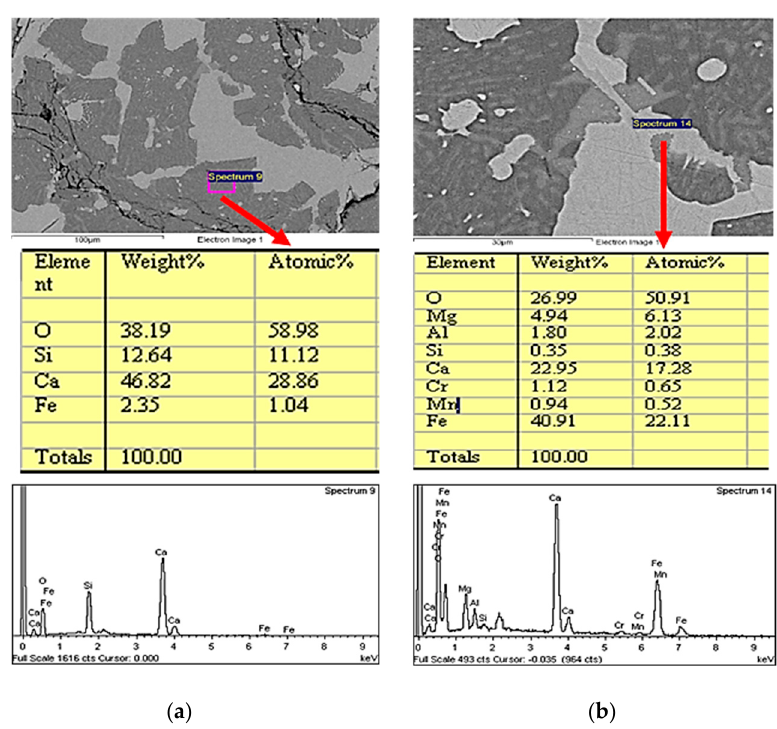
Figure 8. Structure of the slag in Melting Processes D and EDX—the analysis proving the presence of dicalcium silicate and calcium ferrites in the final slag in Melting Process D: ( a ) dicalcium silicate, and ( b ) calcium ferrites.